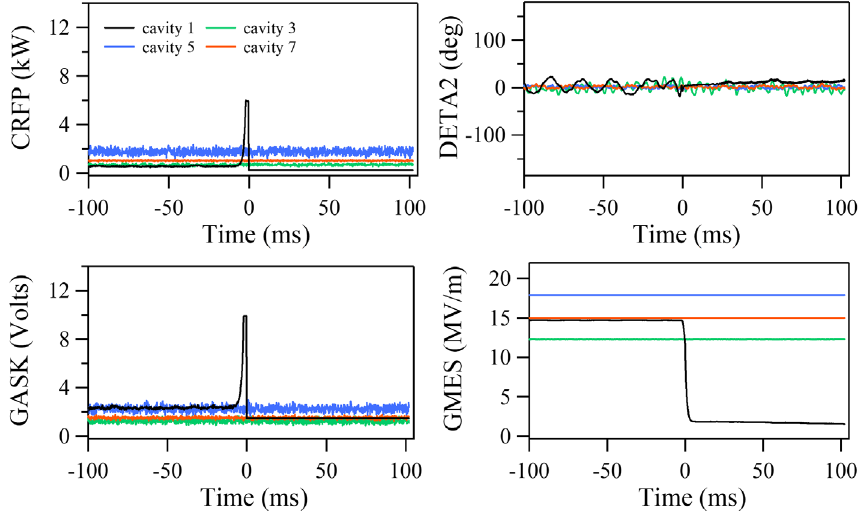
FIG. 14. Waveforms for a 3 ms quench. The plots display the forward power (top left), detune phase angle (top right), a digital signal proportional to the drive voltage (bottom left), and the measured gradient (bottom right). Only four of the eight cavities are plotted for clarity. Note that the scale of the horizontal axis has been modified to begin 100 ms before the fault event.